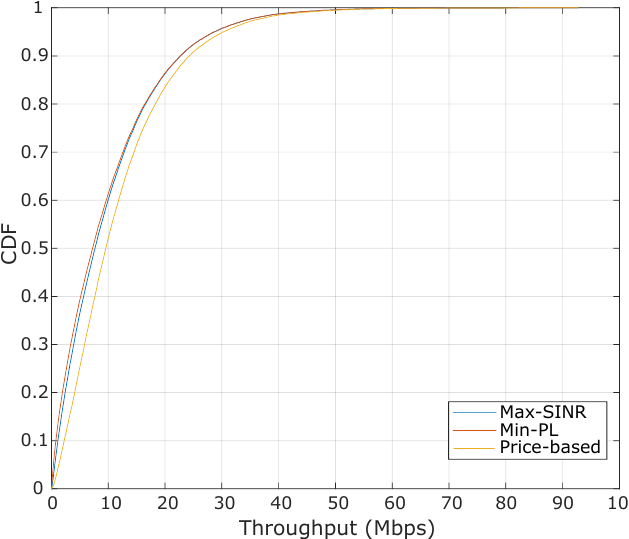
Figure 5. Cumulative distribution function (CDF) of the throughput achieved by each algorithm. The number of HTC and MTC devices per cell is set 10 and 20, respectively. The backhaul capacity is assumed with a value of 12 Mbps.